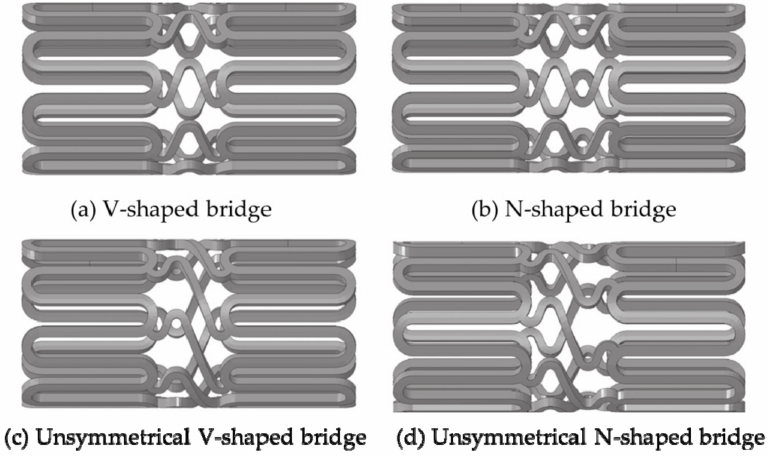
Figure 9. Different bridge structures [92]: ( a ) V-shaped; ( b ) N-shaped; ( c ) Unsymmetrical V-shaped; ( d ) Unsymmetrical N-shaped.